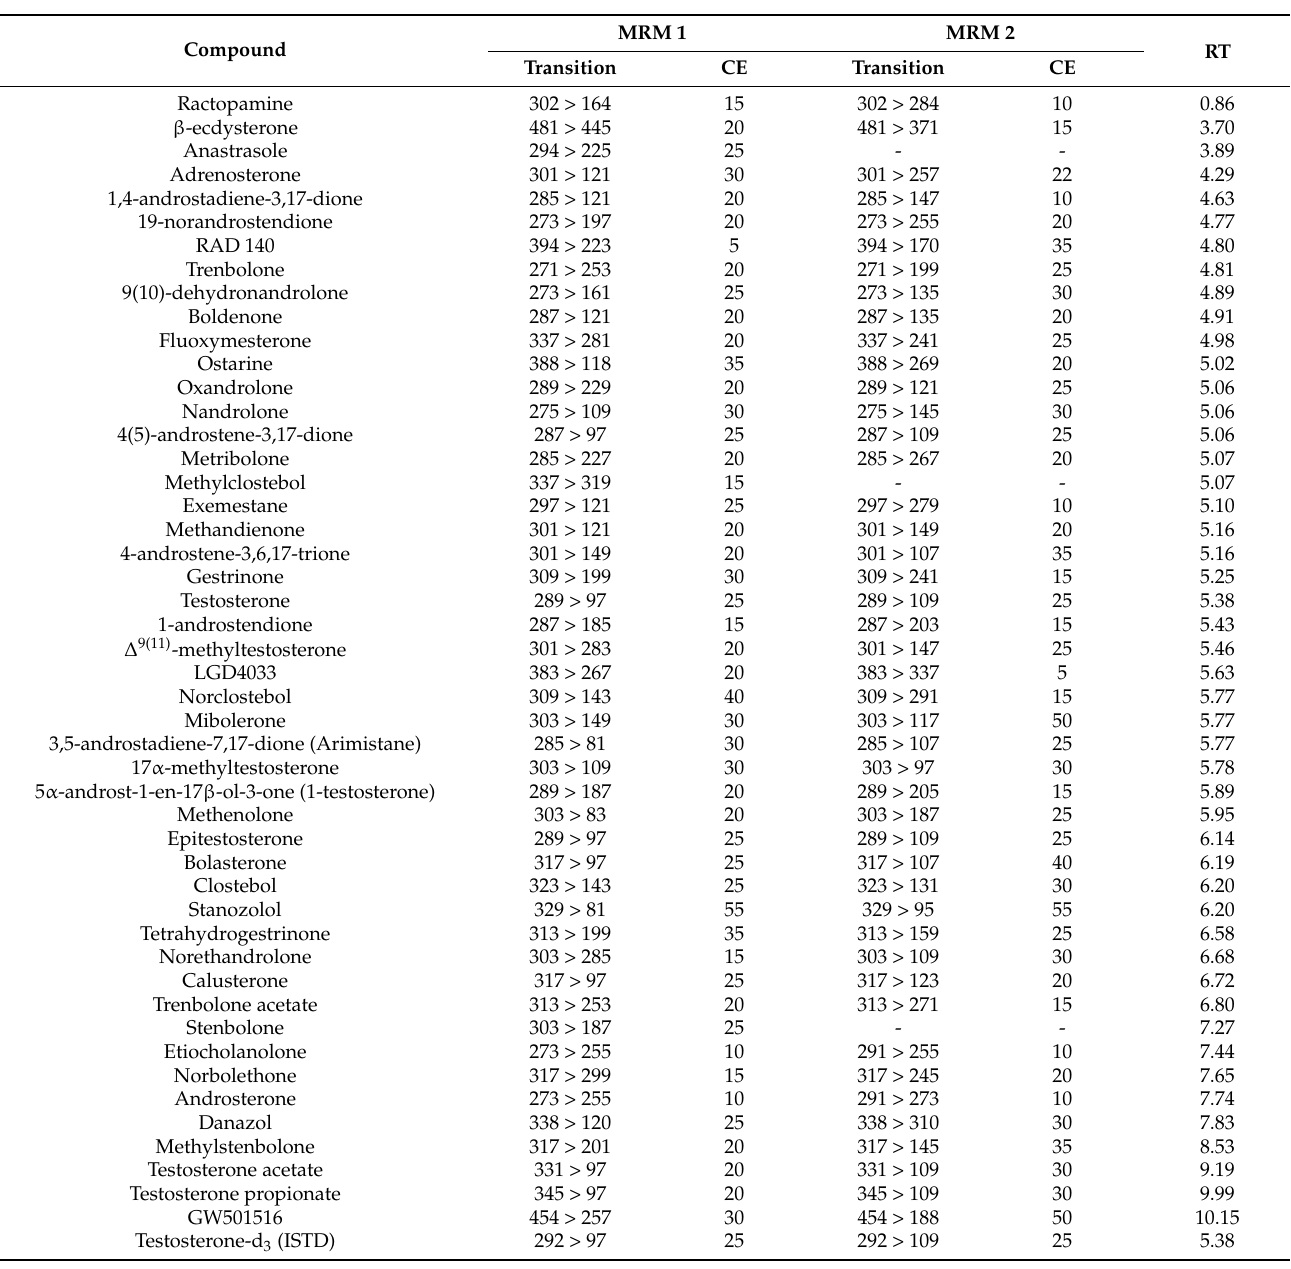
Table 1. MRM transitions and CEs (expressed as eV) of target substances for LC-MS/MS analysis. MRM 1 was used for primary identification; MRM 2 was selected as confirmatory transition. RT was expressed in